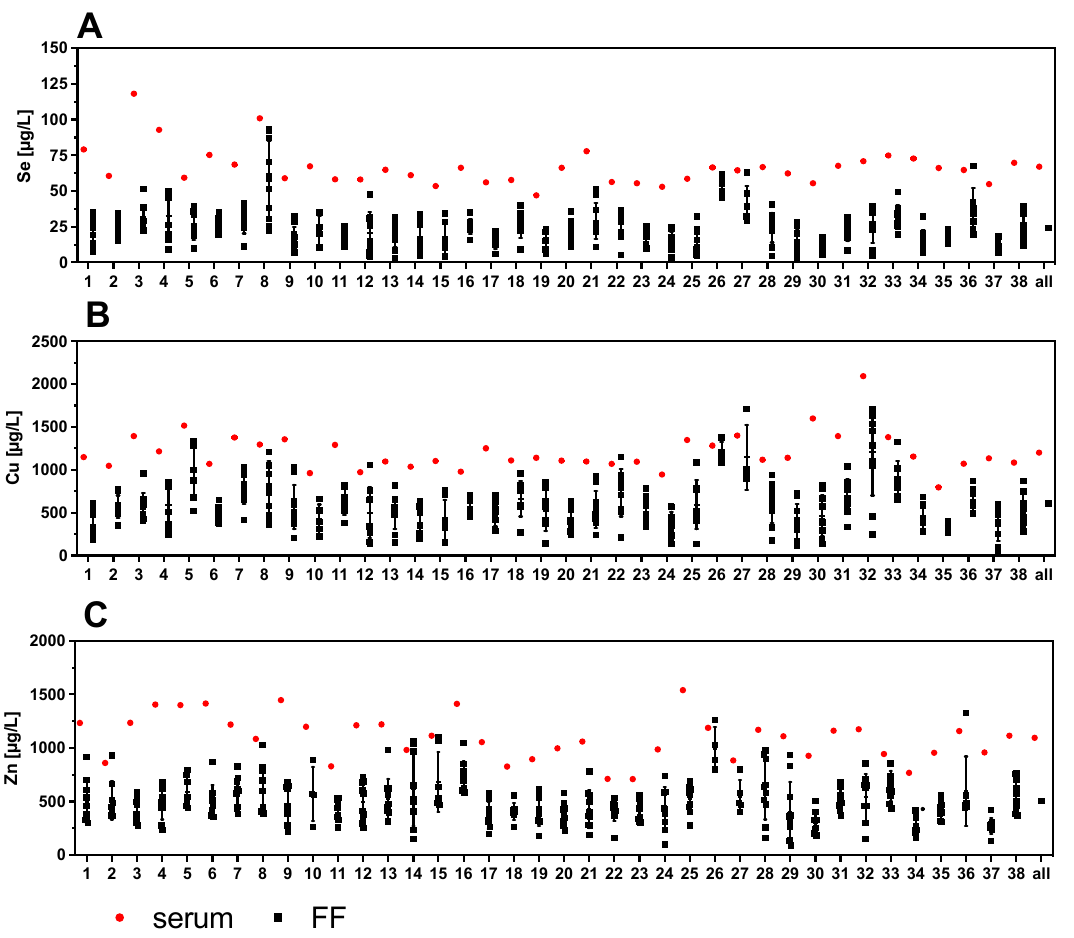
Figure 4. Comparison of TE concentrations in serum and corresponding follicular fluids (FF). Trace element concentrations of one serum sample with up to 10 corresponding FF were compared per patient. The results indicate a wide variation in TE concentrations in the different FF with regards to ( A ) Se, ( B ) Cu, and ( C ) Zn. Samples 20–37 correspond to women with PCOS.